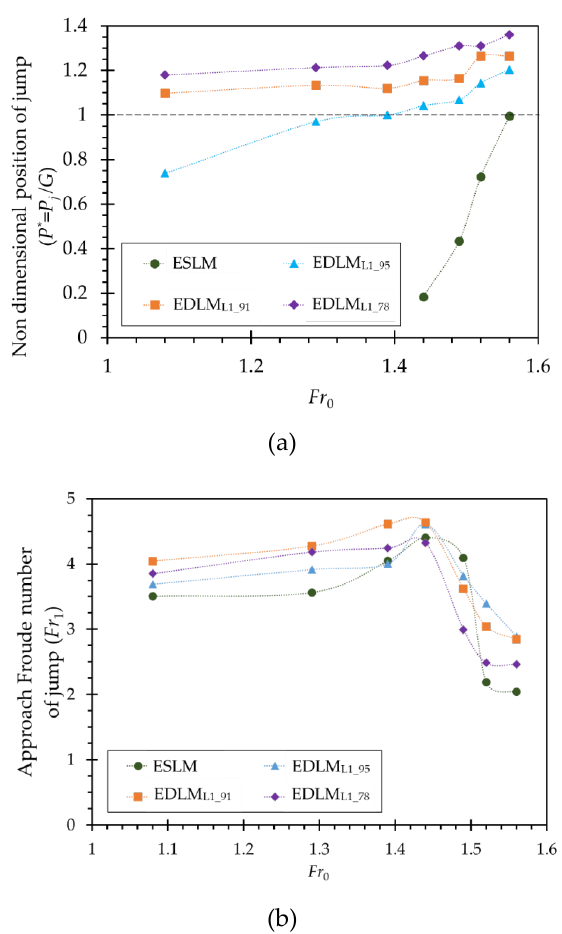
Figure 3. Relationship of initial Froude number ( Fr 0 ) with ( a ) nondimensional position of jump toe ( P * ) from the front line of forest model and ( b ) approach Froude number (in front of jump) of the jump ( Fr 1 ).